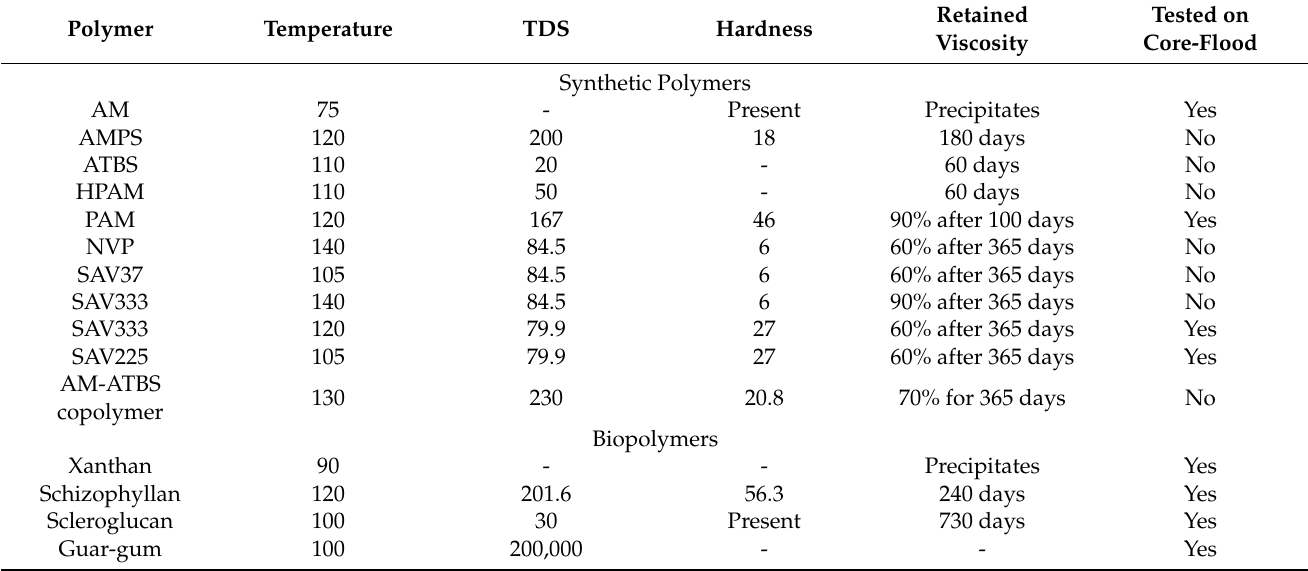
Table 4. Summary of polymers temperature and salinity limits